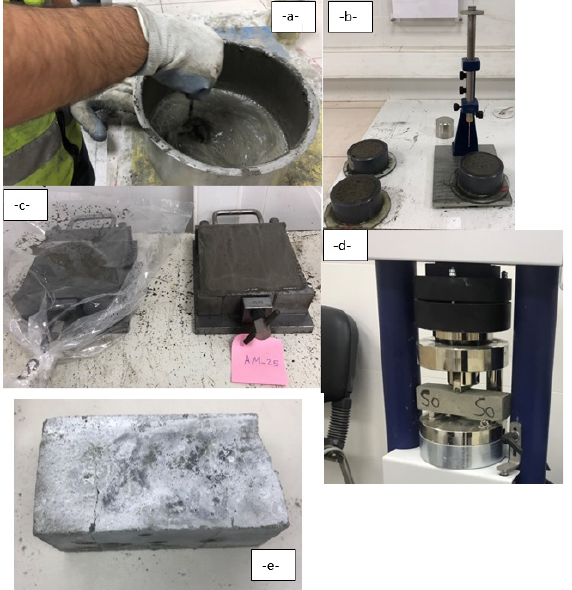
Figure 2: The layout of cement mortar sample for (a) Flexural test (b) Compression test Tensile Bonding strength (CIGMAT CT-3, modified ASTM